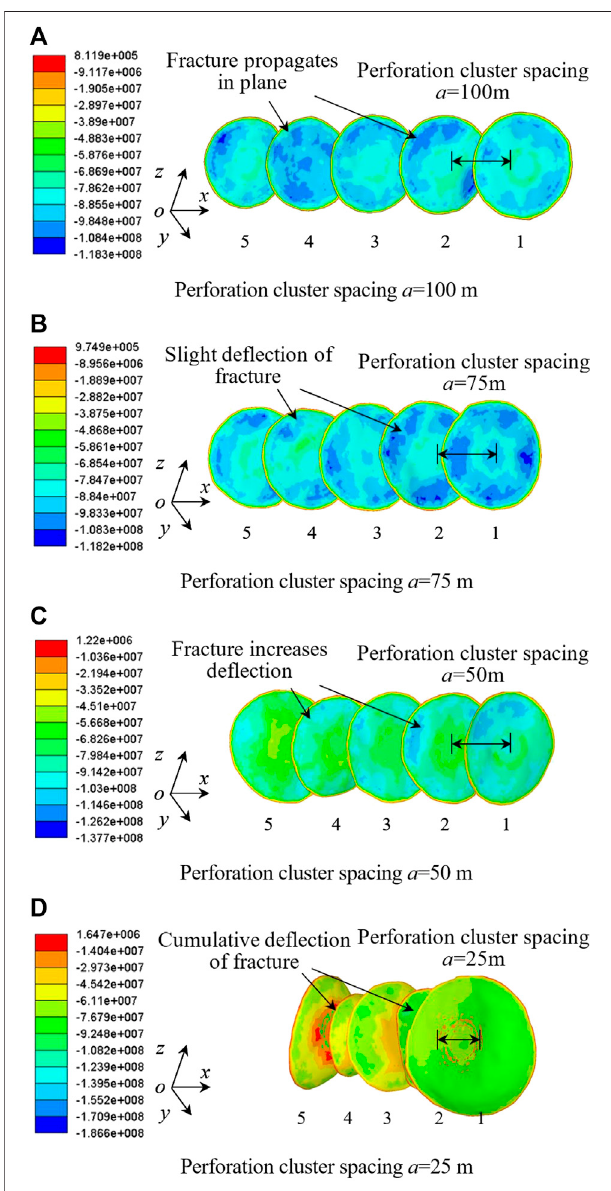
FIGURE 4 | Final morphology of fracture network and stress in alternate